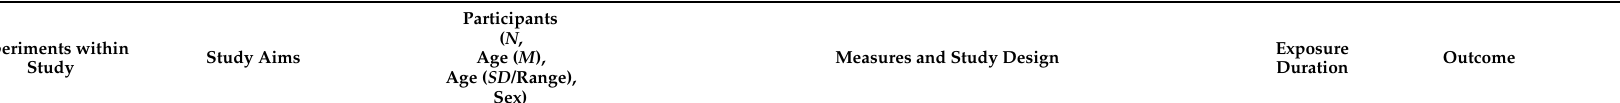
Table 2. Characteristics of included